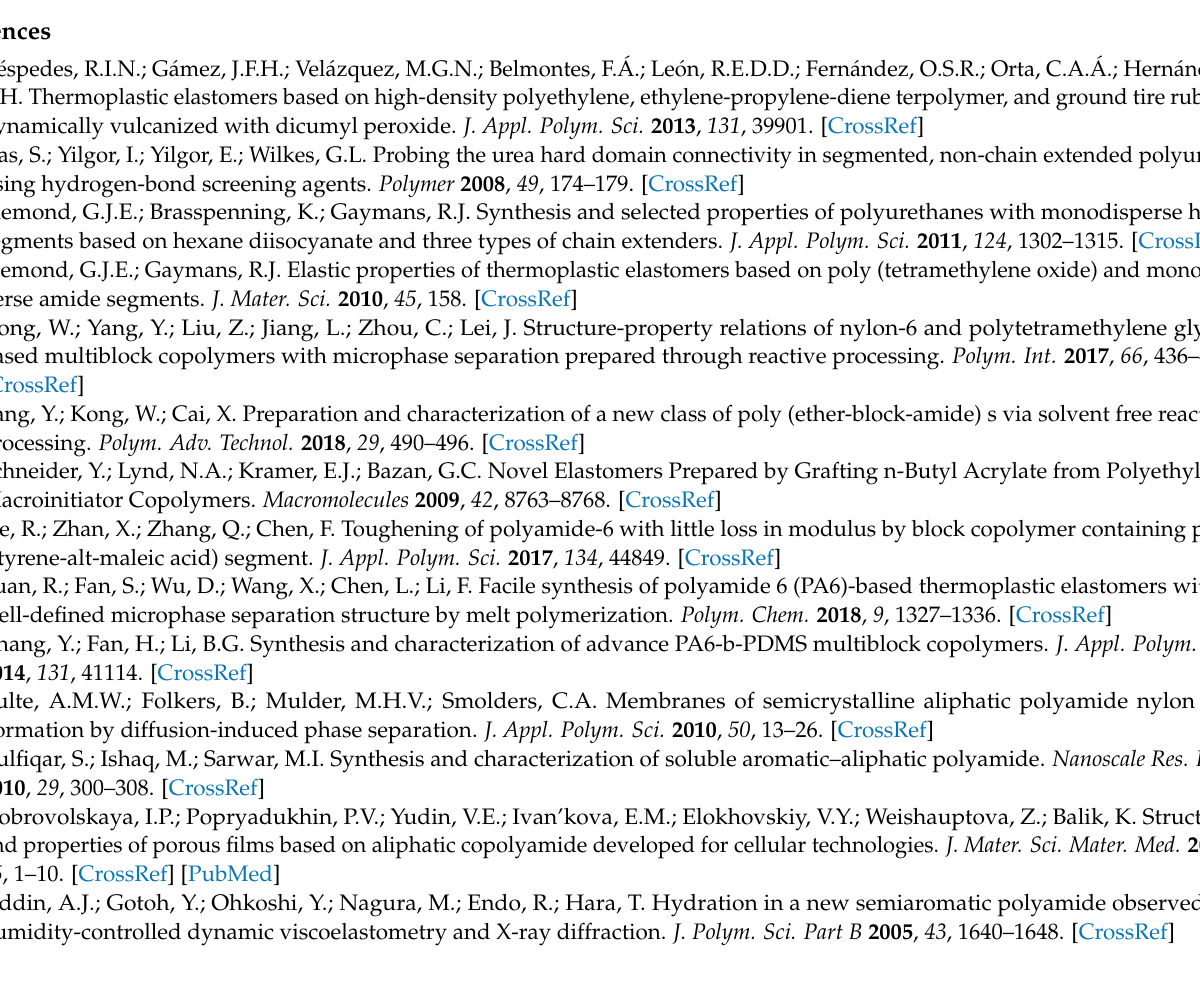
25 ◦ C; Figure S2. High temperature bending test: (a) TPAE-1000; (b) TPAE-1500; (c) TPAE-2000; (d) Pebax®5533; Figure S3. POM micrographs of (a)TPAE-1000, (b) TPAE-1500, (c) TPAE-2000 and (d) PA10T/10I nonisothermally crystallized at 5 °C/min; Figure S4. POM micrographs of (a)TPAE-1000, (b) TPAE-1500, (c) TPAE-2000 and (d) PA10T/10I nonisothermally crystallized at 20